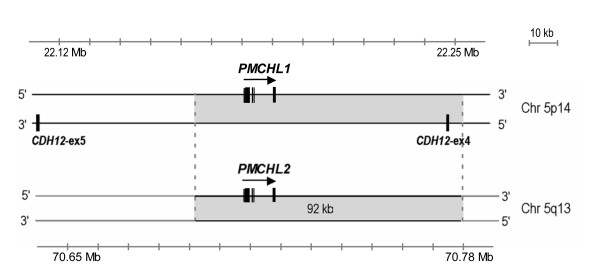
Schematic map of PMCHL gene positions at human chromosome 5p14 and 5q13 loci. The six exons of PMCHL1 locate within 10 kb on chromosome 5p14, on the opposite strand of CDH12 intron 4. PMCHL2 arose by duplication of a 92 kb fragment (in grey) encompassing PMCHL1 onto chromosome 5q13. Positions according to http://www.ensembl.org nomenclature are indicated.